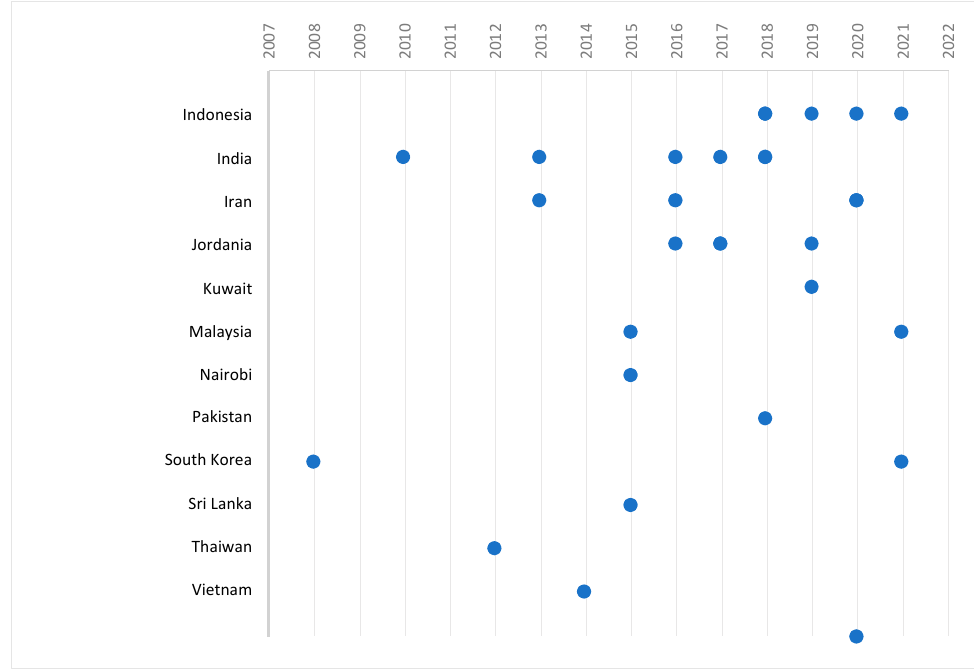
Figure 2. Studies included in the SLR by countries and years of